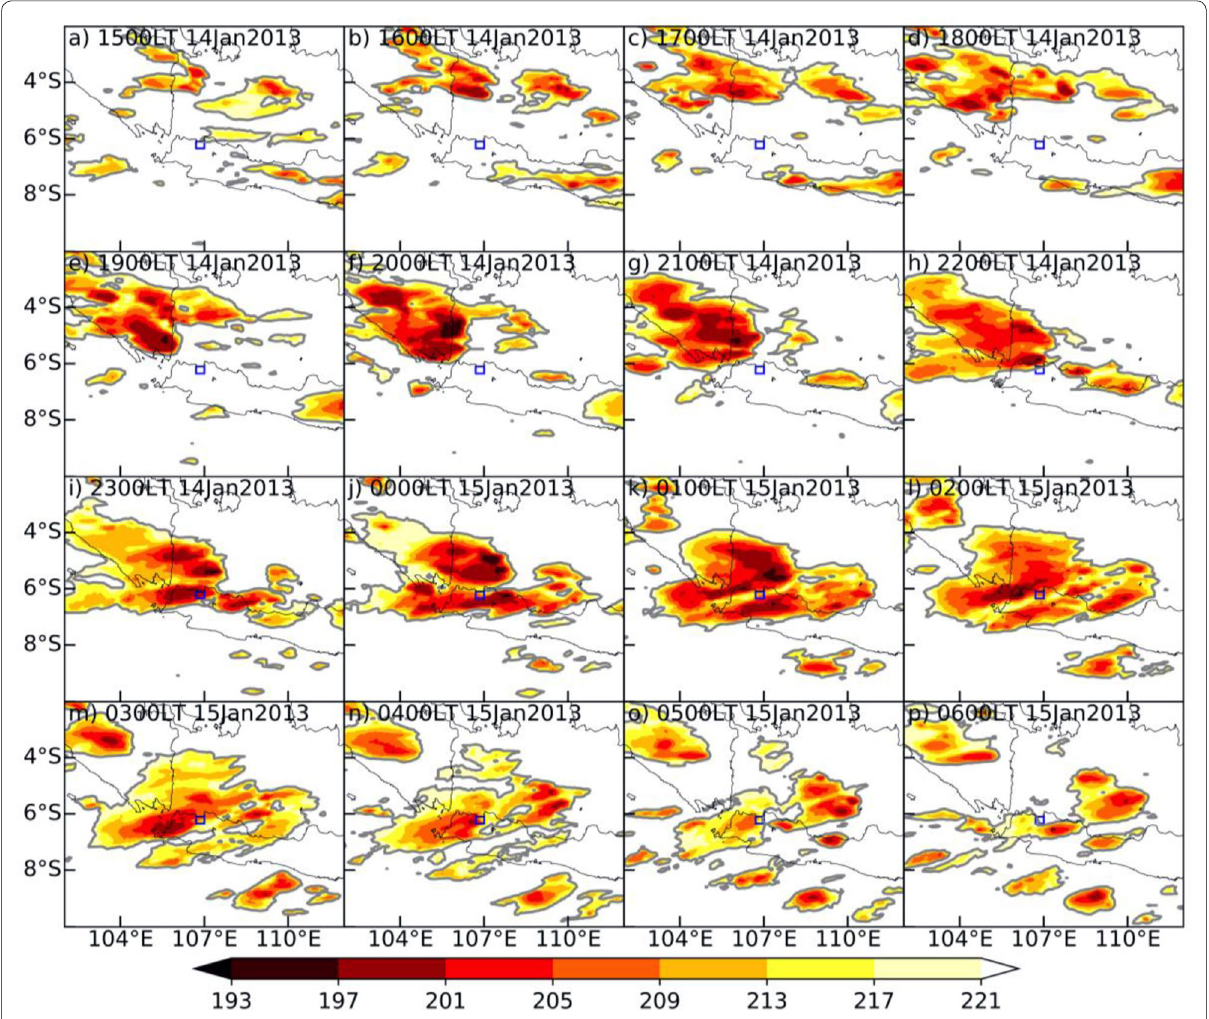
Fig. 5 Horizontal distribution of the equivalent temperature black body (TBB) for the first mesoscale convective system (MCS) criteria from infrared data obtained by MTSAT-1R surrounding the GJ on 14–15 January 2013 a – p showing the stages of MCS evolution: b genesis stage (16:00 LT); e development stage (19:00 LT); k mature stage (01:00 LT); and p dissipation stage (06:00